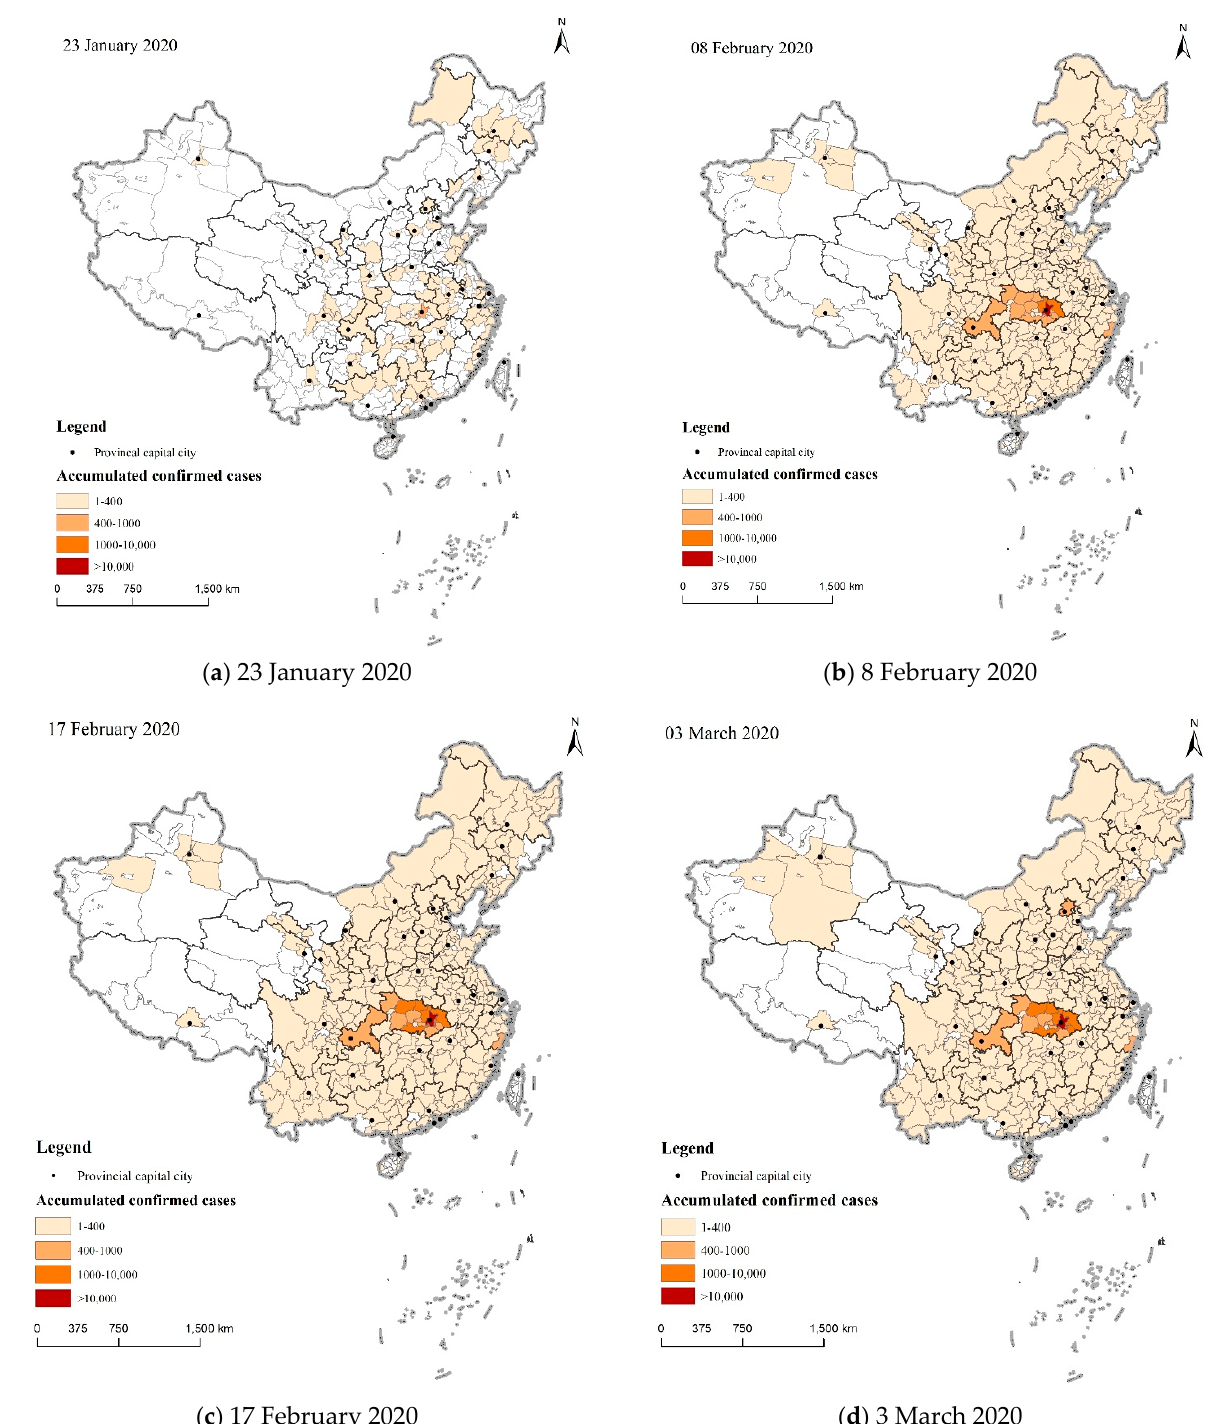
Figure 2. Accumulated numbers of confirmed COVID ‐ 19 cases in China on different dates. ( a ) 23 January 2020; ( b ) 8 Feb ‐